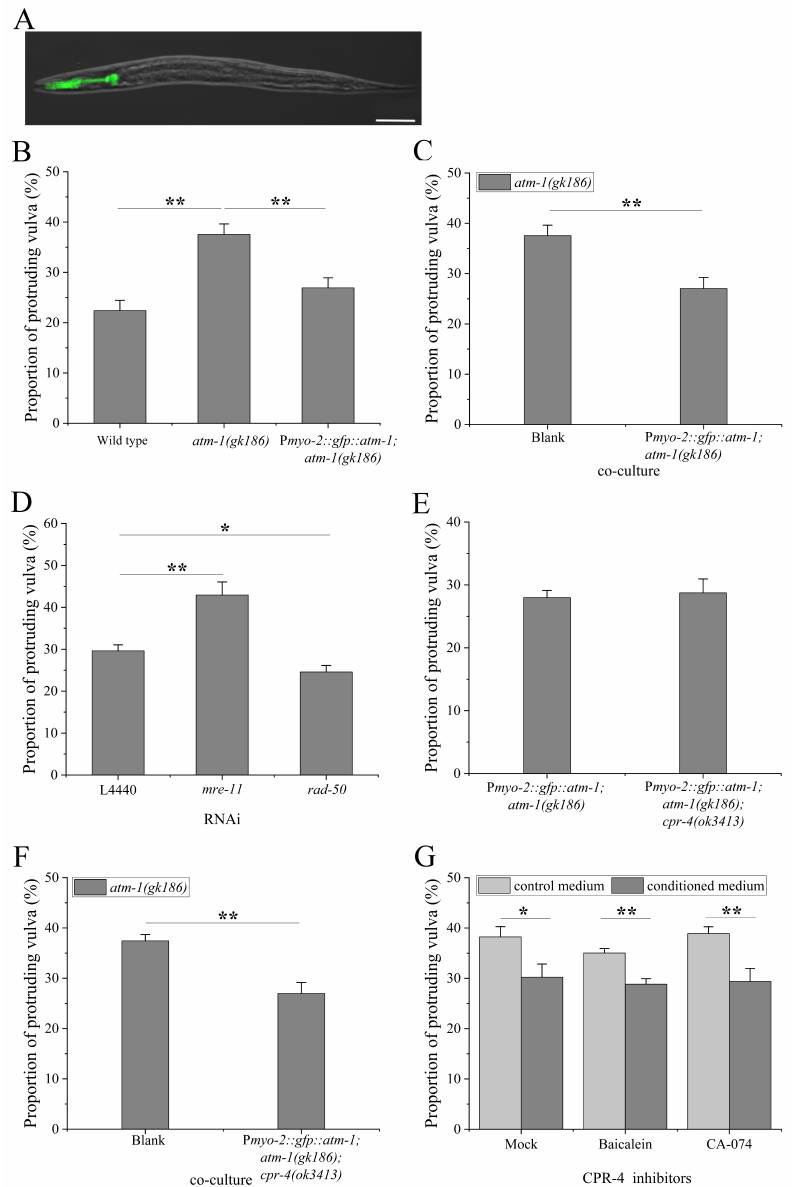
Figure 7. Inter-tissue regulation of pharyngeal ATM cascade on vulval radiosensitivity: ( A ) pharynx- specific expression of the atm-1 gene in worm line BPL1221: P myo-2::gfp::atm-1; atm-1(gk186) , scale bar: 50 µ m; ( B ) the vulval radiosensitivity of BPL1221 worms; ( C ) the vulval radiosensitivity of atm-1 worms co-cultured with BPL1221 worms, Blank: culture alone; ( D ) the vulval radiosensitivity of BPL1221 worms subjected to RNAi of mre-11 and rad-50 genes; ( E ) the vulval radiosensitivity of worm line BPL1231: P myo-2::gfp::atm-1; atm-1(gk186); cpr-4(ok3413) ; ( F ) the vulval radiosensitivity of atm-1 worms co-cultured with BPL1231 worms, Blank: culture alone; ( G ) the vulval radiosensitivity of atm-1 worms cultured in the conditioned medium of BPL1221 worms treated with CPR-4 inhibitors baicalein and CA-074, respectively. Results are means ± SD ( n ≥ 3, t -test, * p < 0.05 and ** p <